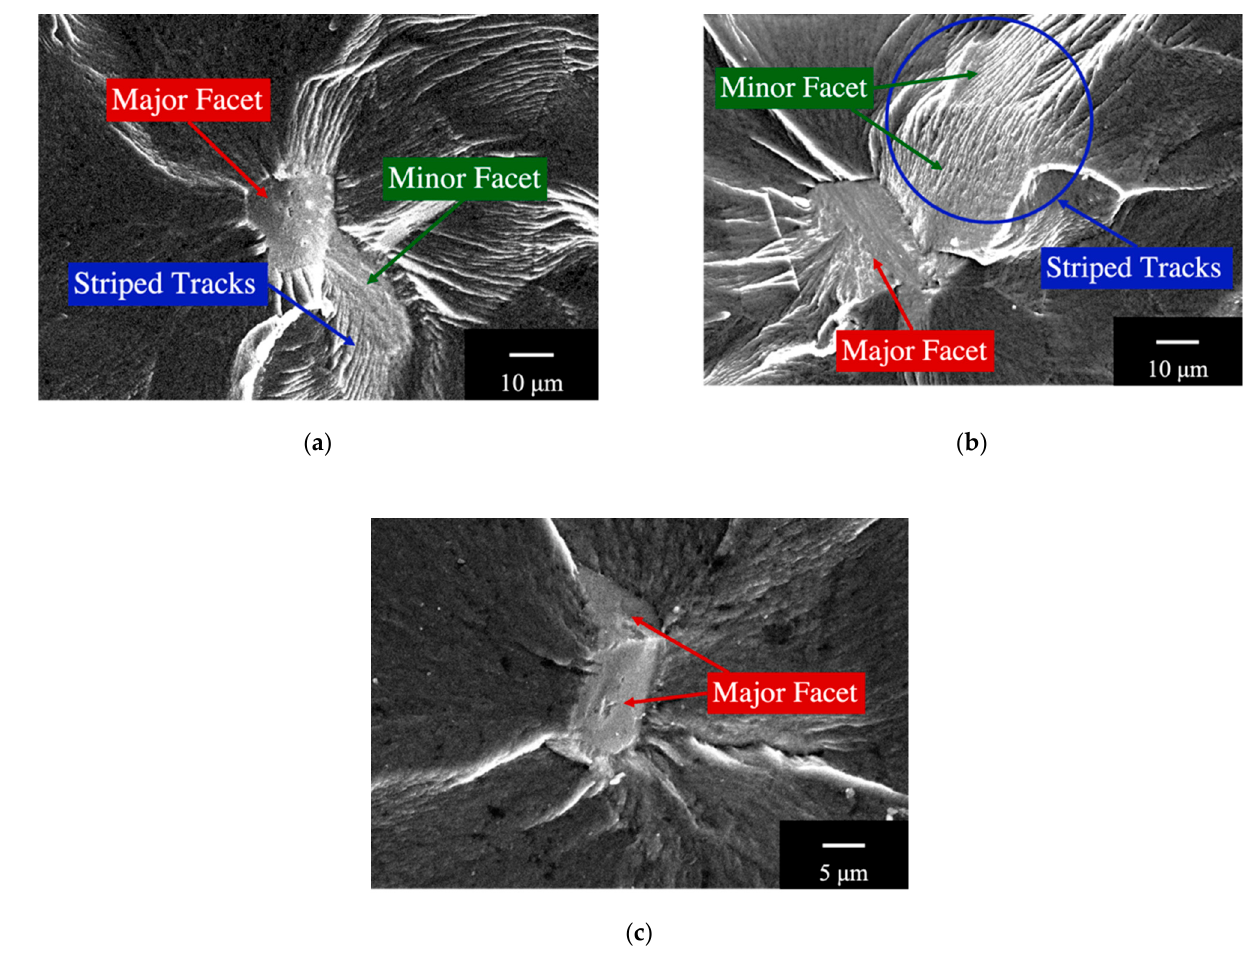
Figure 6. SEM images of the multiple facets under positive stress ratio. ( a ) σ max = 1125 MPa, R = 0.1, N f = 6.5 × 10 4 ; ( b ) σ max = 975 MPa, R = 0.1, N f = 4.5 × 10 6 ; ( c ) σ max = 1000 MPa, R = 0.1, N f = 3.0 × 10 5 .